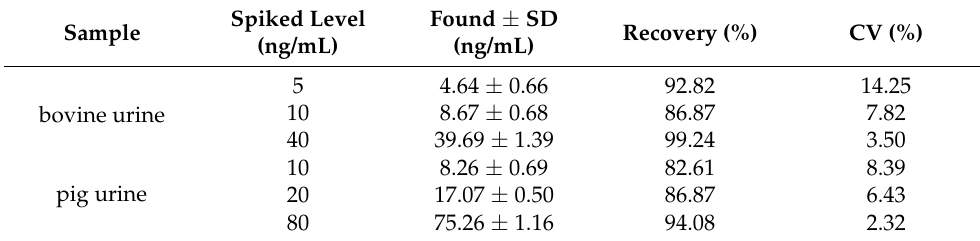
Figure 11. Correlations of analysis of samples spiked with 19-NT between ic-ELISA and UPLC– MS/MS. 4. Conclusions In this study, three specific Nbs against 19-NT were successfully selected from the camel immune nanobody library and their characteristics were identified. Then, a series performance analysis based on the selected Nbs were carried out. The results showed that the Nb2F7 had better thermostability, higher tolerance to organic solvents and especially good sensitivity and specificity for 19-NT. An ic-ELISA method for the detection of 19-NT in animal urine was further developed using Nb2F7, which had high sensitivity for 19-NT